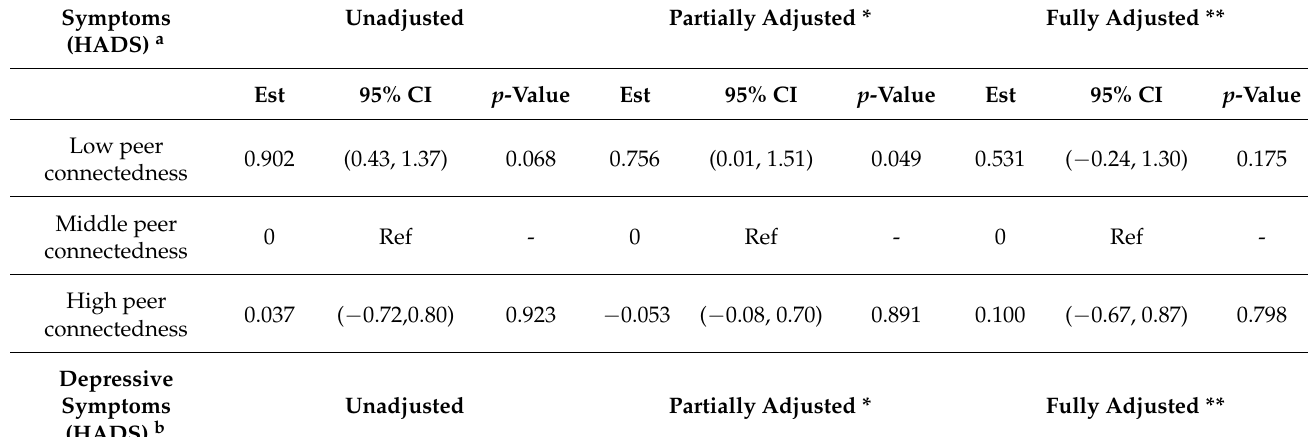
Table 4 reports the association between pre-pandemic levels of peer connectedness and the changes in anxious and depressive symptoms and well-being scores between lockdown (time 2) and the return to school (time 3). Low peer connectedness was associated with an increase in anxious symptoms within the partially adjusted model ( β = 0.756, p = 0.049, 95% CI [ − 0.01, 1.51]); however, findings attenuated to the null following adjustment for school connectedness ( β = 0.531, p = 0.175, 95% CI [ − 0.24, 1.30]). Consistent with the findings for school connectedness, we did not find differences in outcome change scores for students with high compared to medium levels of peer connectedness for anxious symp-